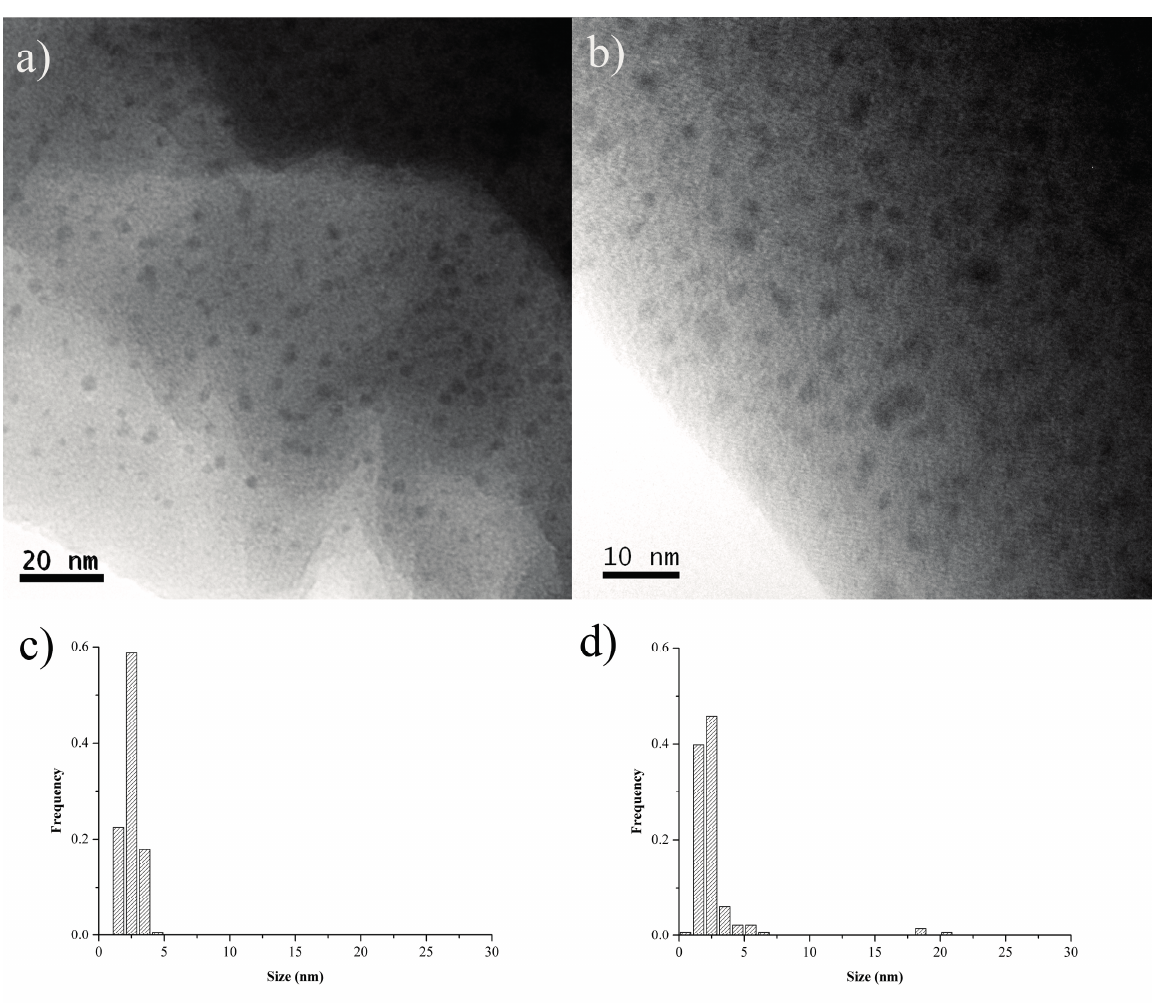
Figure 11. TEM high enlargement images of Pd-pol after the ( a ) first and ( b ) seventh cycle of the quinoline reduction using NaBH 4 at 60 °C in water. Pd NPs particle size distributions of Pd-pol after the ( c ) first and ( d ) seventh cycle of the quinoline reduction using NaBH 4 at 60 °C in water (reaction conditions reported in Table